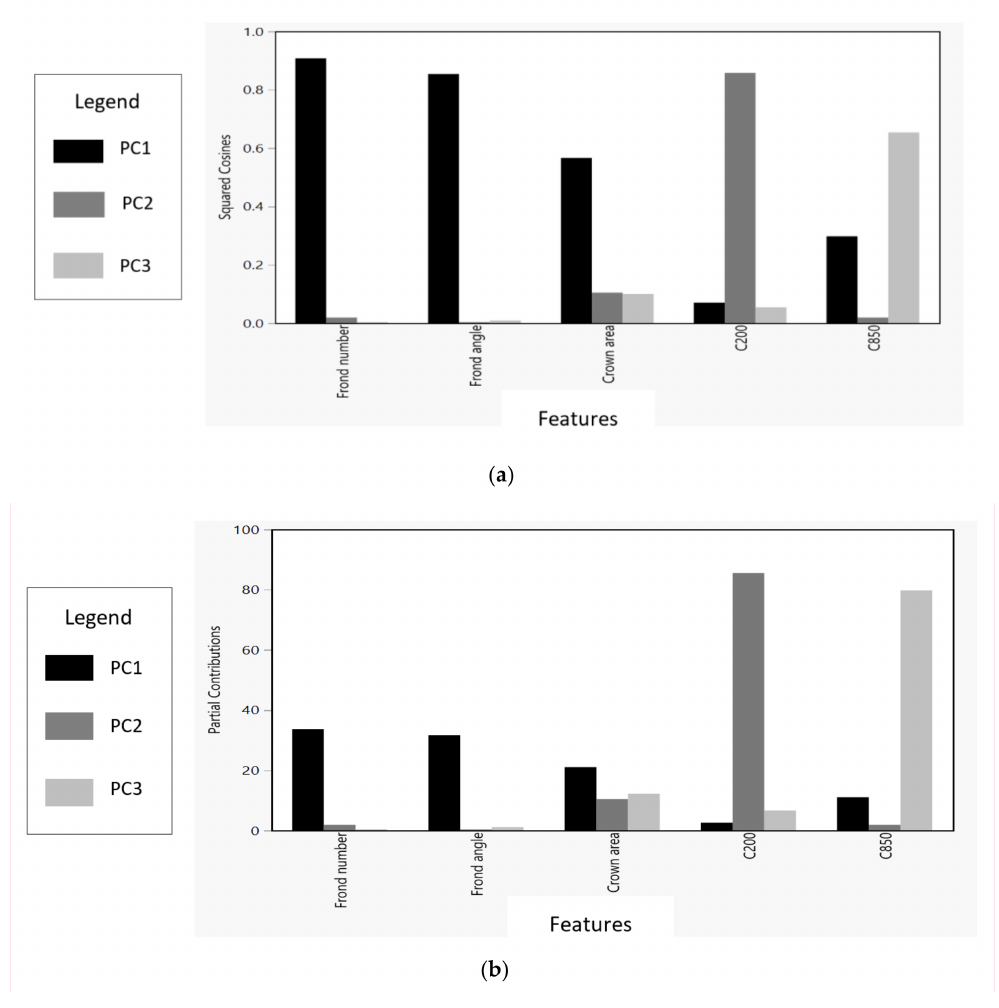
Figure 6. ( a ) Squared cosines of the features and ( b ) partial contributions of the